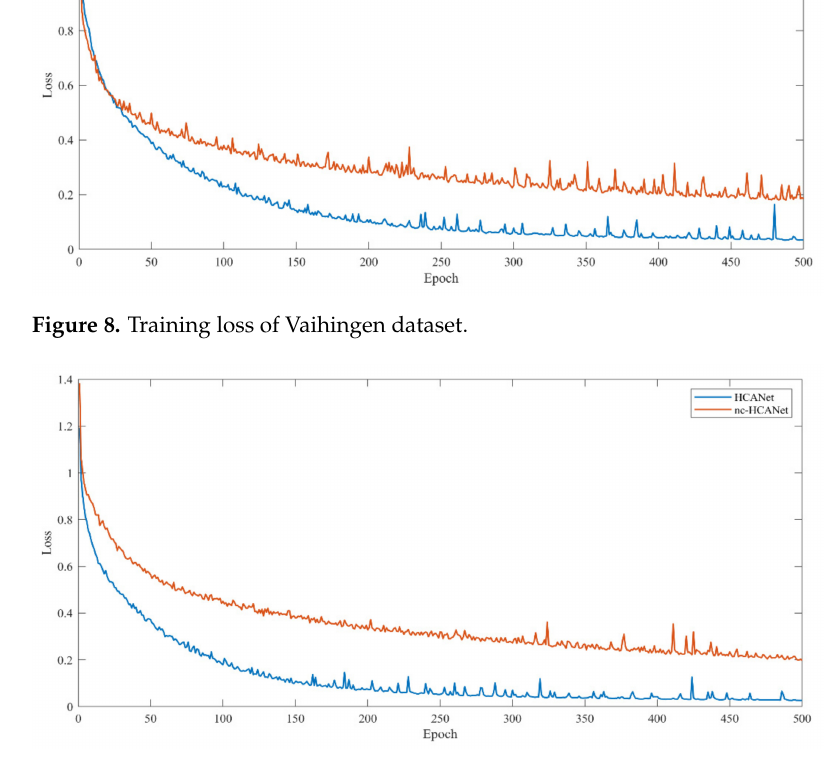
Figure 9. Training loss of Vaihingen